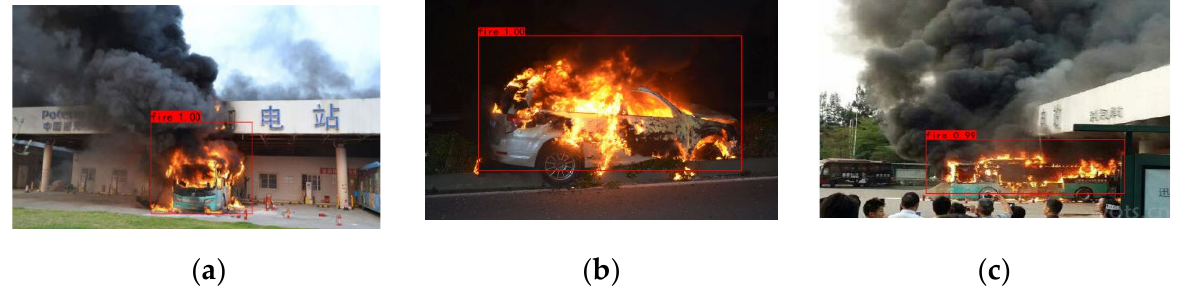
Figure 15. Test results of YOLOv4-Kmeans. ( a ) Sufficient light; ( b ) Insufficient light; ( c ) Long- range target.